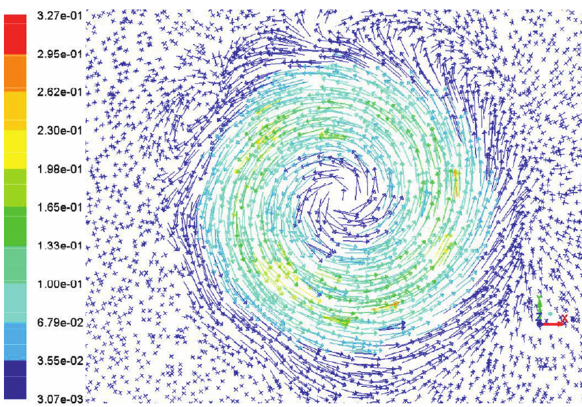
Figure 11: Material flow behavior of section c at the plunging